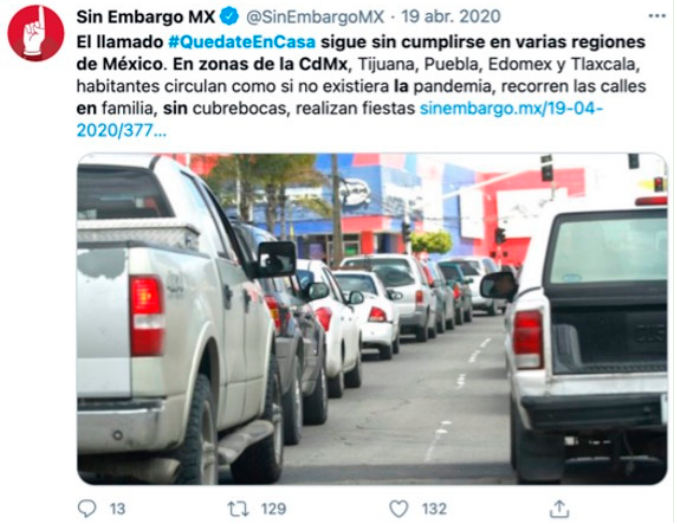
Figure 11. Example of sample content 5.